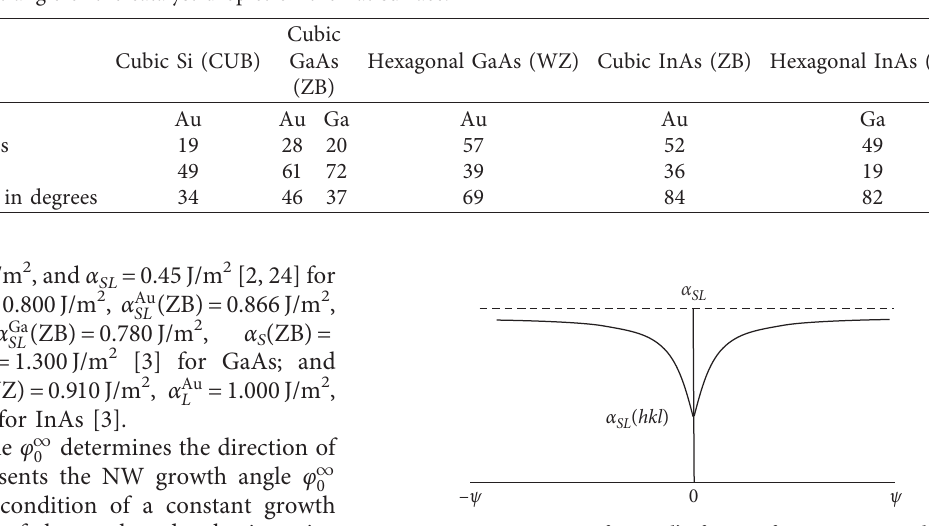
Table 1: Inclination angle of the curved surface of the crystallization front, growth angle of Si, GaAs, and InAs NWs in the presence of Au and Ga particles, and contact angle of the catalyst droplet on the flat surface.